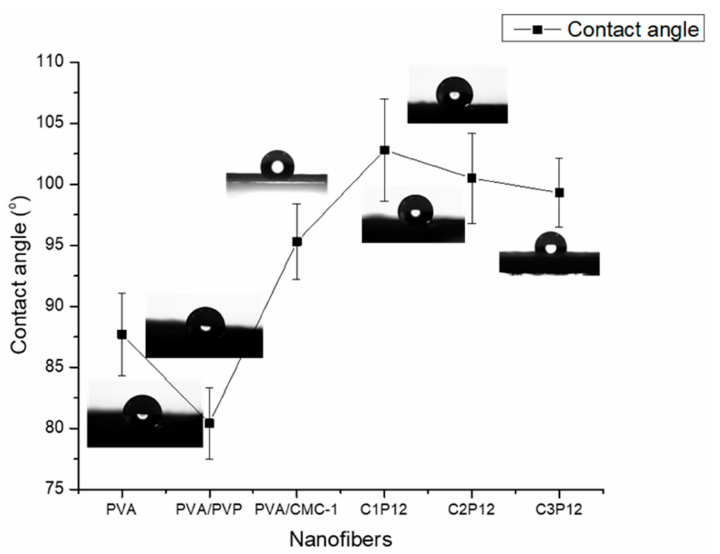
Figure 4. Water contact angles (WCA) of PVA, PVA/PVP, and CMC based composite